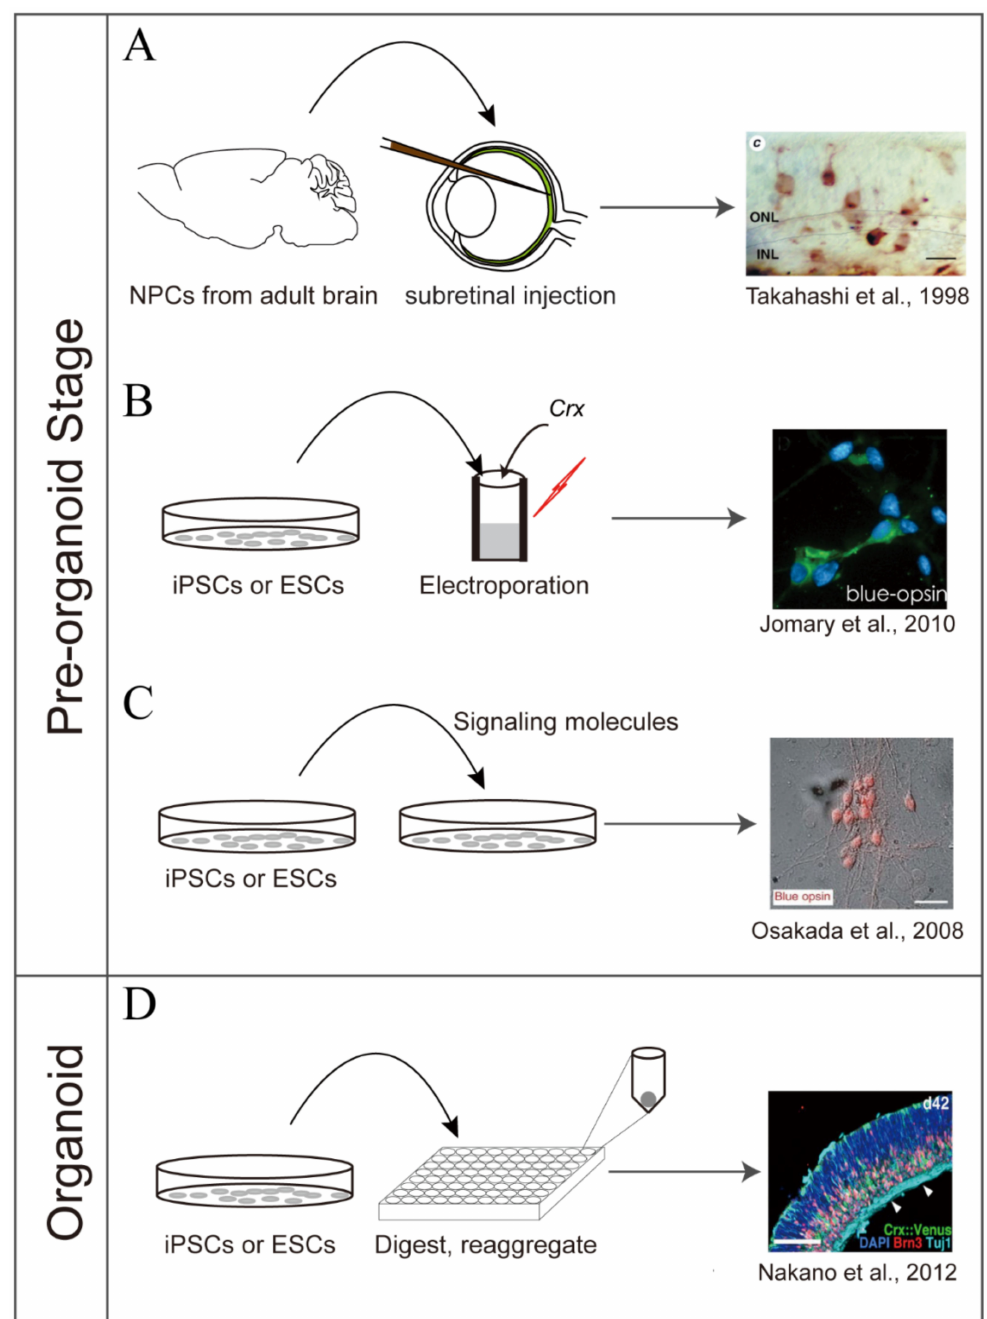
Figure 1. The methodological history of inducing retinal cells. ( A – C ) During the pre-organoid stage, the retinal cells were induced by transplanting NPCs/RPCs into the retina in vivo, misexpressing retinal transcription factors in the ESCs/iPSCs, or culturing these cells with proper signaling molecules. ( A ) NPCs purified from the adult rat hippocampus were injected intravitreally and they differentiated into photoreceptor-, amacrine-, bipolar-, horizontal-, and Müller-like cells in the host retina. ( B ) The cone-rod homeobox gene Crx was overexpressed in mouse retinal stem cells or human ocular stem cells and induced them to the cone-like photoreceptor. ( C ) The ESCs and iPSCs can also be induced into photoreceptors by signaling molecules, such as SHH, DKK1, retinoic acid, and taurine. ( D ) The retinal organoids with laminar structures were induced from mouse/human ESCs and were capable of recapitulating the characteristics of native retinas. DKK1, Dickkopf WNT Signaling Pathway Inhibitor 1; ESCs, embryonic stem cells; INL, inner nuclear layer; iPSCs, induced pluripotent stem cells; NPCs, neural progenitor cells; ONL, outer nuclear layer; SHH, sonic hedgehog. The right four panels are adapted with permission from Refs. 2, 9, 13, and 21,